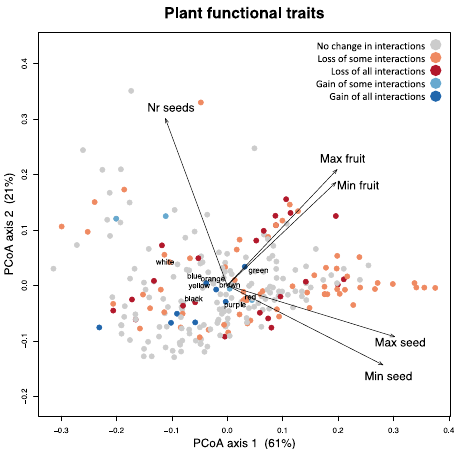
Fig. 5 | Functional trait space of native Mauritian fl eshy-fruited plants. Func- tionaltraitspaceofallnative fl eshy-fruitedplantsonMauritiusbymeansofaPCoA ( n =263 plant species, PCoA, Gower distance, Supplementary Fig. 2, 25% missing data imputed with 80% accuracy, Supplementary Table 3). Arrow directions indi- cate the relationships between maximum and minimum size dimensions of seeds andfruits,andthenumberofseedsperfruit.Thefruitcolorpositionsareindicated withtheirnames.Pointsindicateplantspecies,andtheircolorsindicatechangesin known plant – frugivore interactions due to extinctions and introductions of frugi- vores. There was no change in known fruit-feeding interactions (gray), loss of one or more interactions (orange), loss of all known interactions with the plant (red), gainofsomeknowninteractions(lightblue)orgainofallknowninteractions(dark blue). Notice the loss of interactions throughout the trait space and the gain of interactions with small seeds and fruits only. Plant names and axis values in Sup- plementary Data